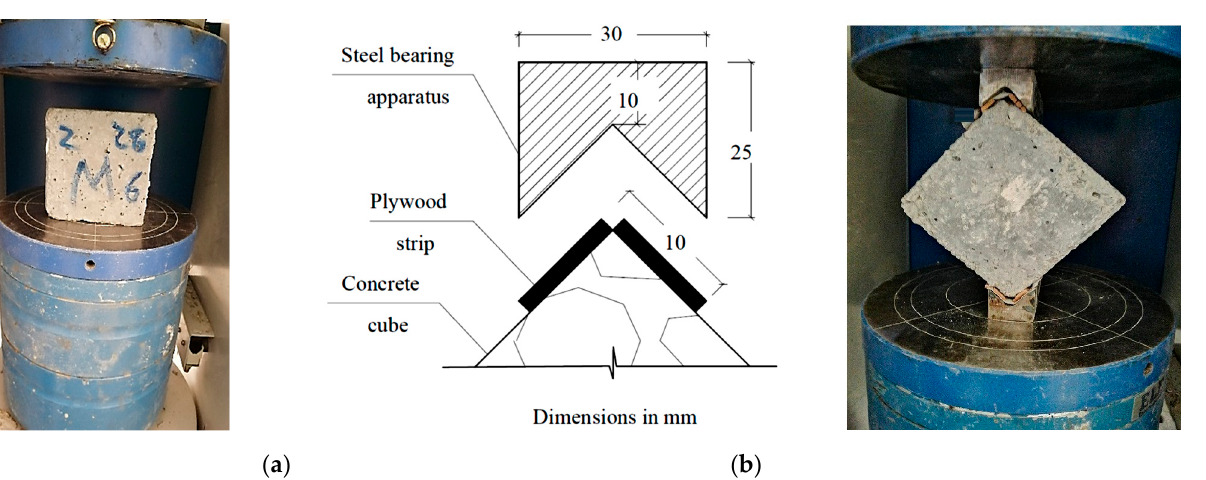
Figure 4. Details of the compression and diagonal cube-splitting tests: ( a ) compression test; ( b ) diagonal splitting test.